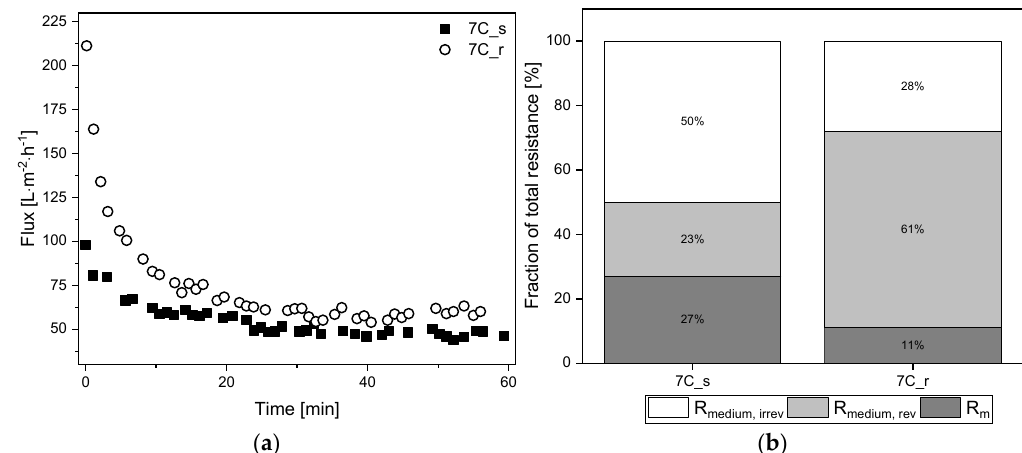
Figure 9. Filtration flux curves and calculated percentage resistances of cell-free medium (TMP = 0.5 bar, CFV = 0.8 m s − 1 , temperature = 25 °C) using 30 nm tubular UF membranes 7C_s and 7C_r. ( a ) The flux curve (J ss begins at 60 min). ( b ) Partition of resistances caused by the filtration of cell-free medium. The sum of the reversible and irreversible resistance is R medium . The sum of R m and R medium is R medium, tot . The 100% values correspond to a total resistance R medium, tot of 3.44 × 10 12 m − 1 for 7C_s, and 3.08 × 10 12 m − 1 for 7C_r.